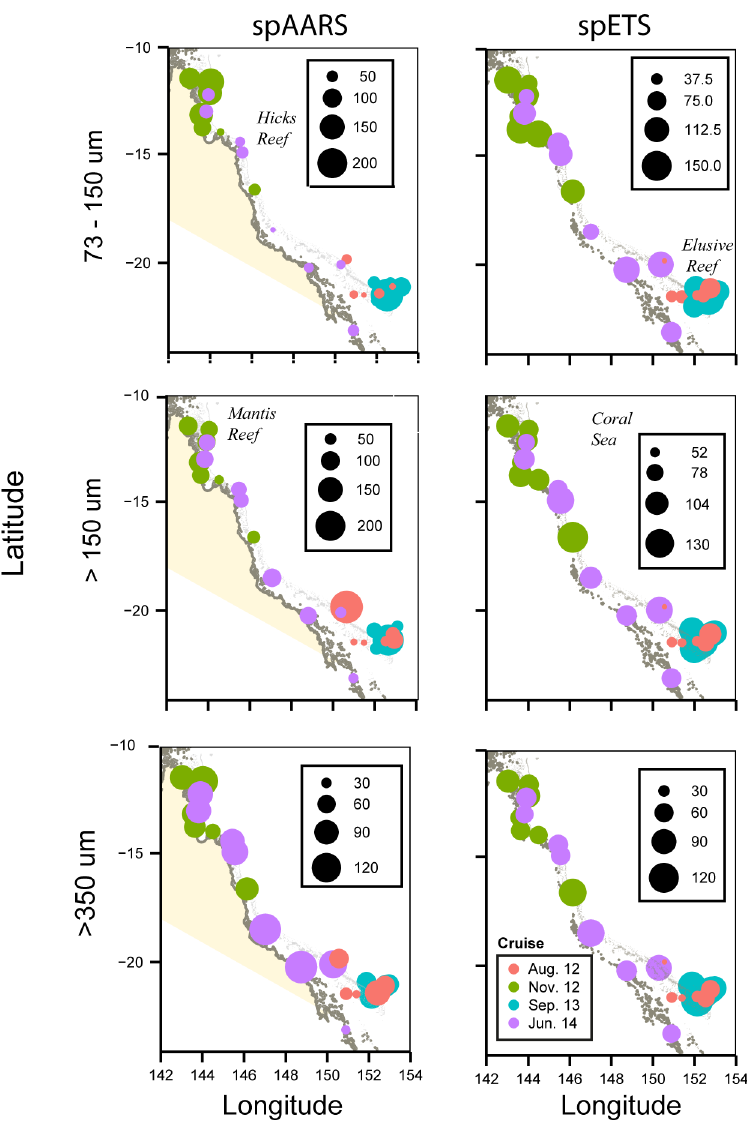
Fig 6. Enzyme activities (spAARS: nmol PPi hr -1 mg protein -1 ; spETS: μ L O 2 hr -1 mg protein -1 ) in the Great Barrier Reef region (see Table 1).